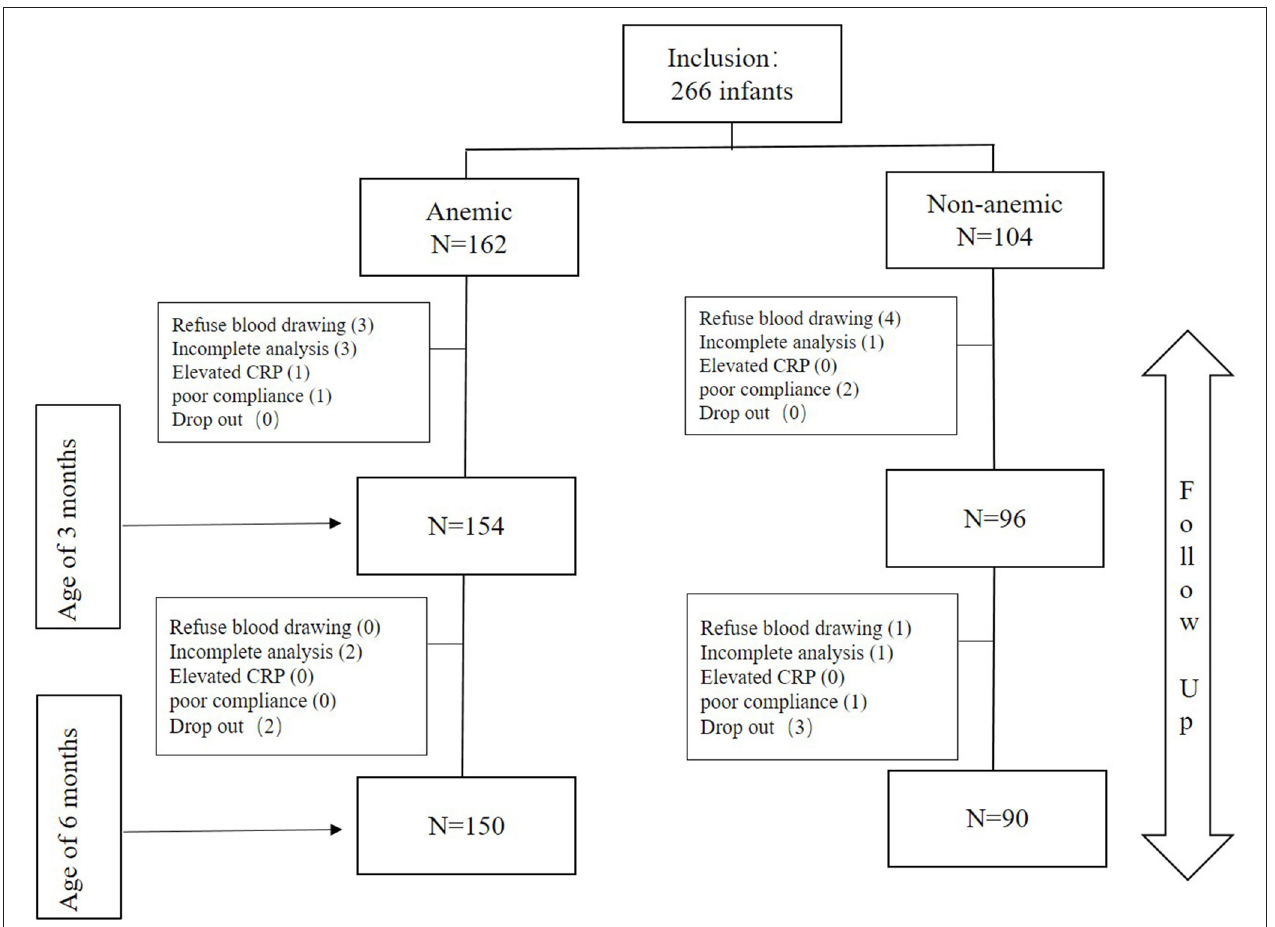
FIGURE 1 | Flow chart of the study